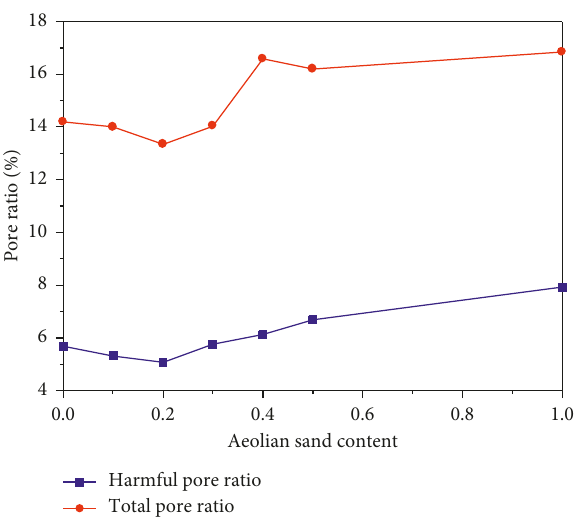
Figure 8: Pore size distribution curves of